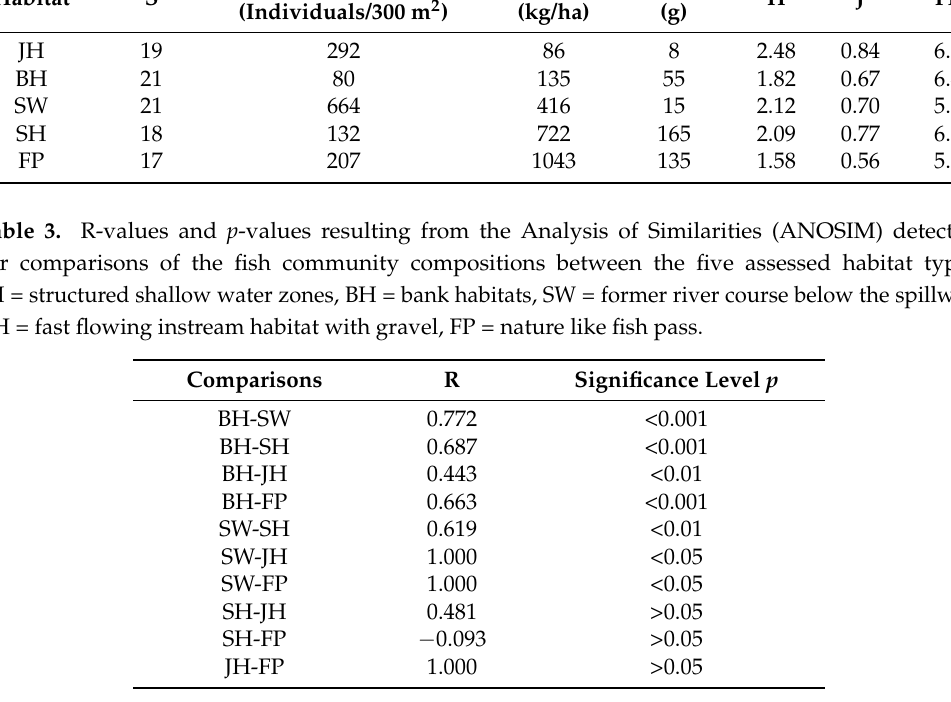
Table 2. Overview of the results in the five assessed habitat types JH = structured shallow water zone, BH = bank habitats, SW = former river course below the spillway, SH = fast flowing instream habitat with gravel, FP = nature like fish pass. S = number of species, CPUE = catch per unit effort of number of individuals (Individuals/300 m 2 ), M = biomass (kg/ha), MFM = mean fish weight (g), H = Shannon-Index, J = Evenness, FRI = fish regions index (Dußling et al. 2005 [38]). CPUE Habitat